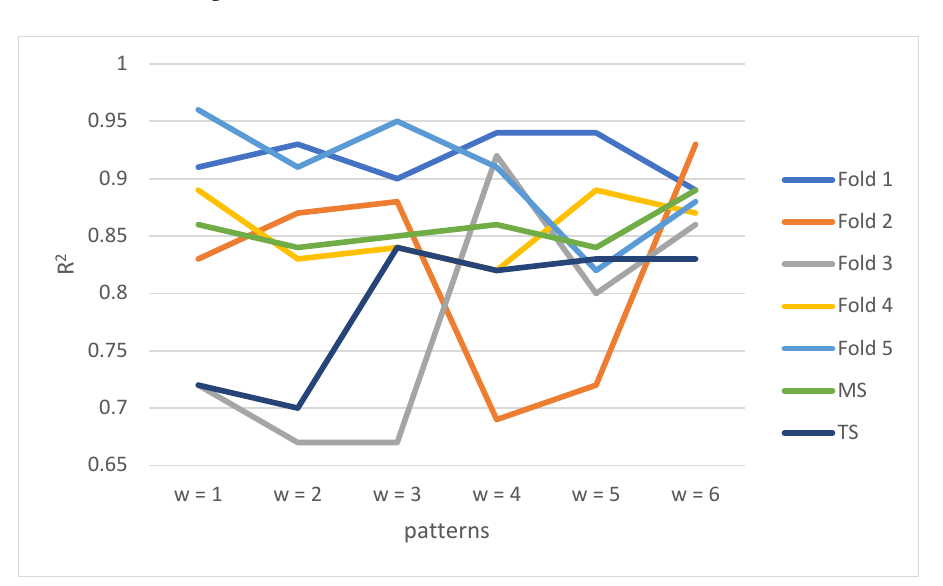
Figure 9. Metrics comparison in the validation set and the test set for LASSO.